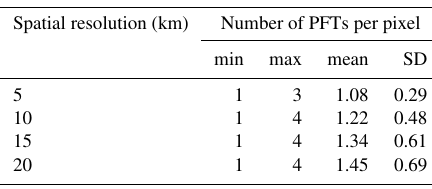
Table A2. Descriptive statistics of the number of PFTs per pixel, by pixel spatial resolution (km): min is minimum, max is maximum, mean is average, and SD is standard deviation.